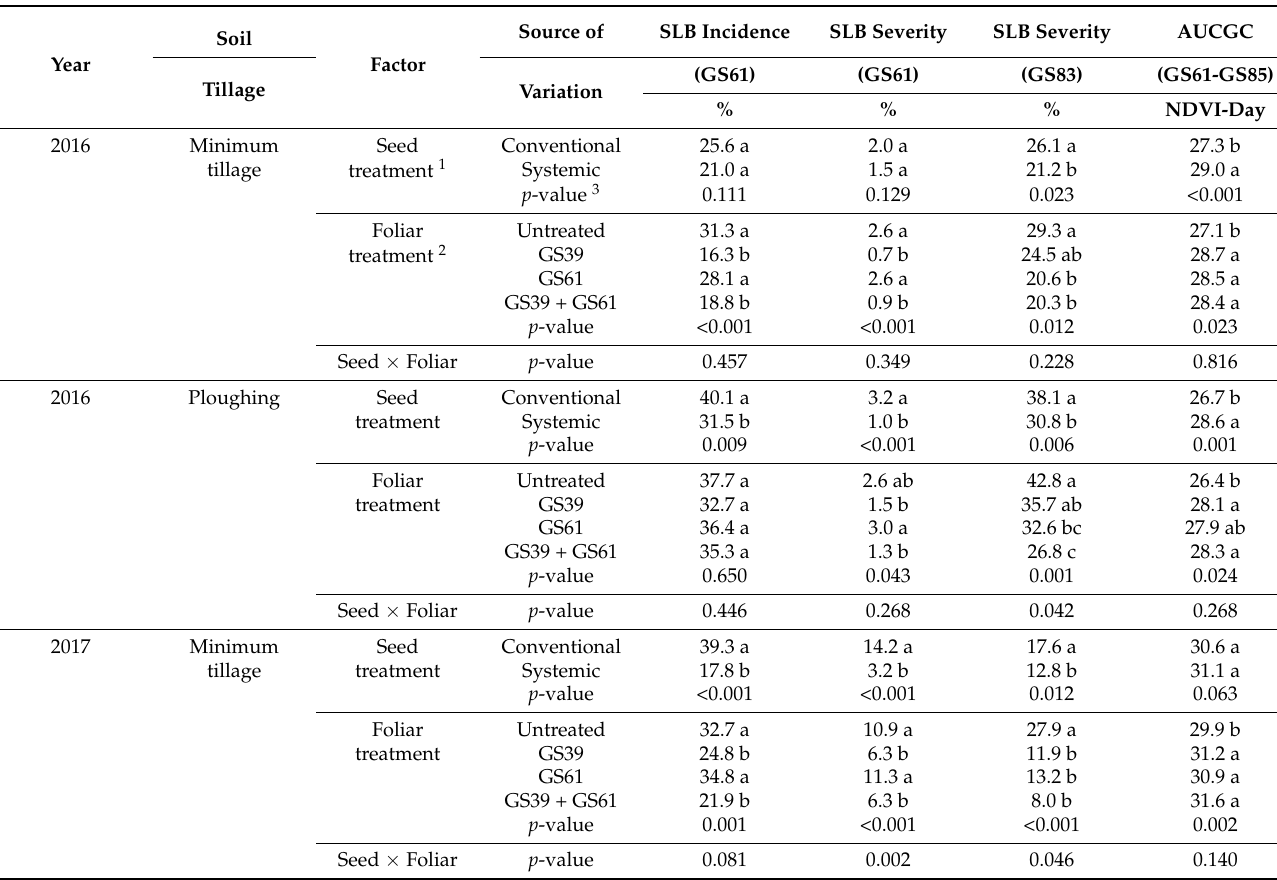
Table 2. Effect of the fungicide seed and foliar treatments on Septoria Leaf Blotch (SLB) incidence and severity at flowering (GS 61), at early dough (GS83) and on the Area Under the Canopy Greenness Curve (AUCGC) detected during the vegetative stages, from the beginning of flowering (GS61) to the soft dough stage (GS85). 2015–2016 and 2016–2017 growing seasons,